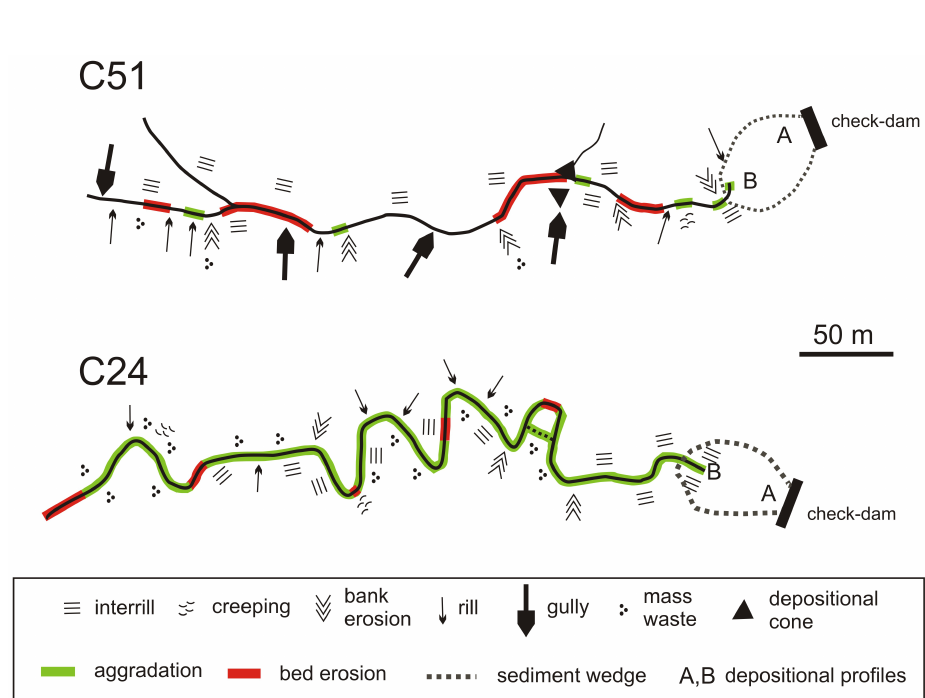
Fig. 2. Schematic geomorphological representation of the two streams indicating the main erosion and depositional processes.